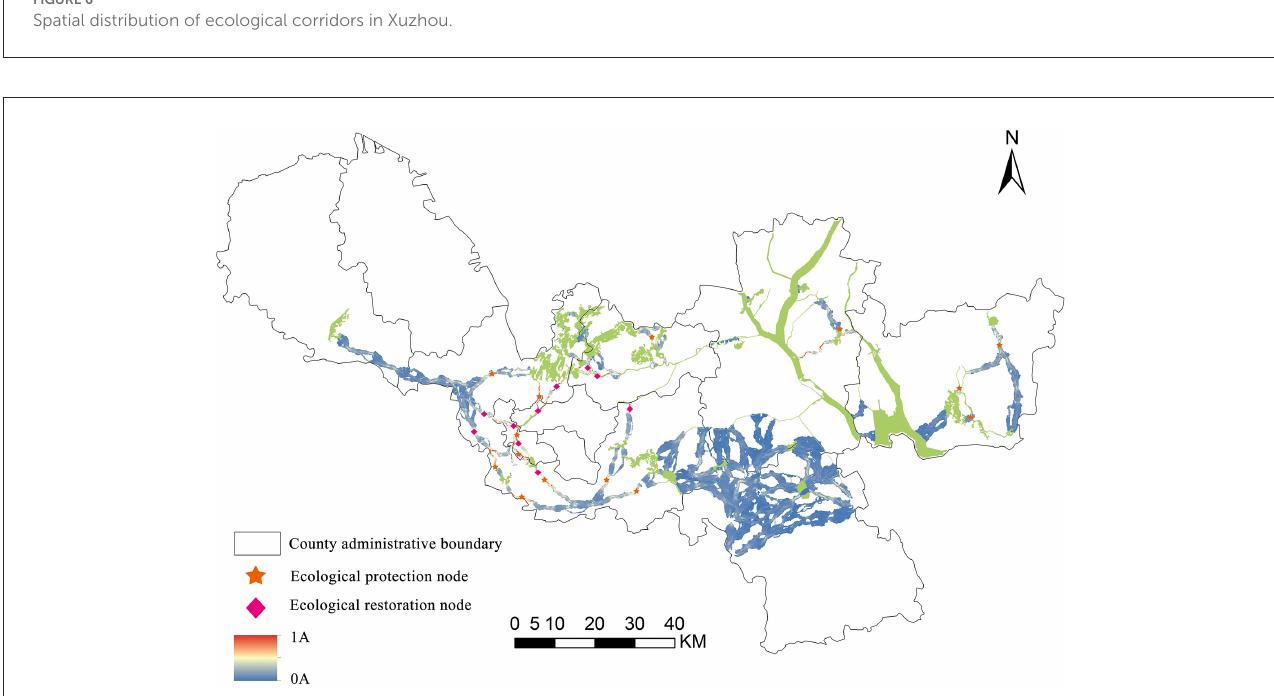
FIGURE6 Spatial distribution of ecological corridors in Xuzhou.